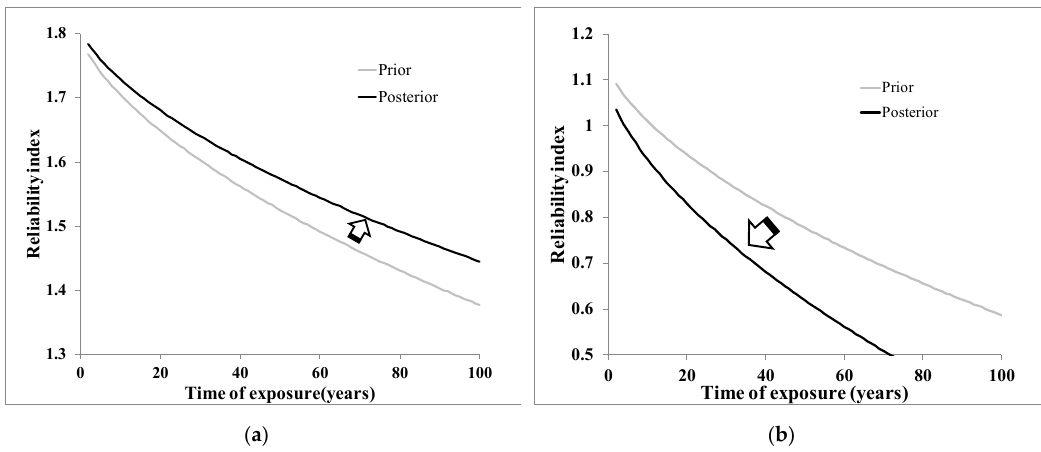
Figure 8. Changes in prior and posterior predicted values for reliability index of the subject bridge. ( a ) Gajwa IC viaduct; ( b ) Geoje bridge.